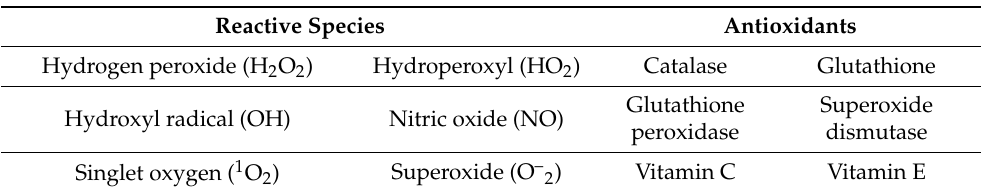
Table 1. Non-exhaustive list of reactive species generated by UV radiation and endogenous antiox- idants found in the skin.